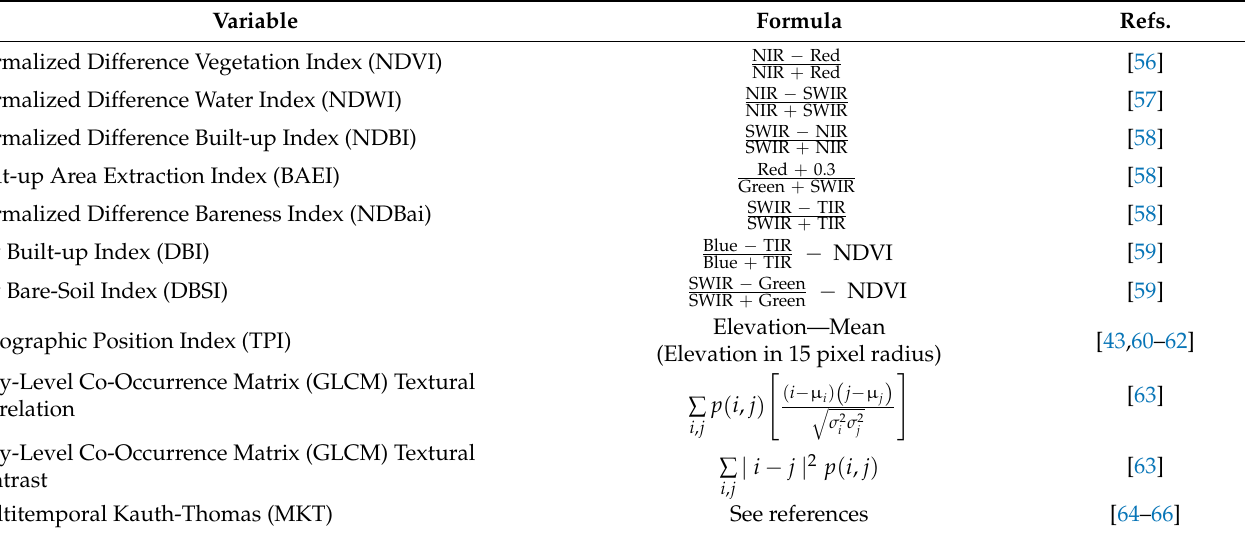
Table 1. Names, formulas and references for indices, Landsat data transformations and ancillary data used as predictor variables in land cover